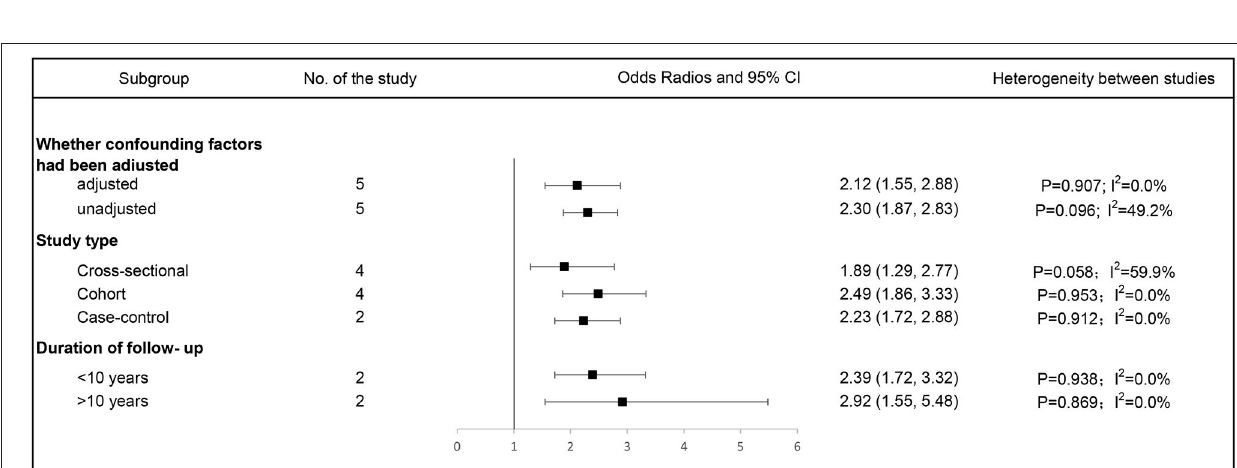
Frontiers in Aging Neuroscience | www.frontiersin.org